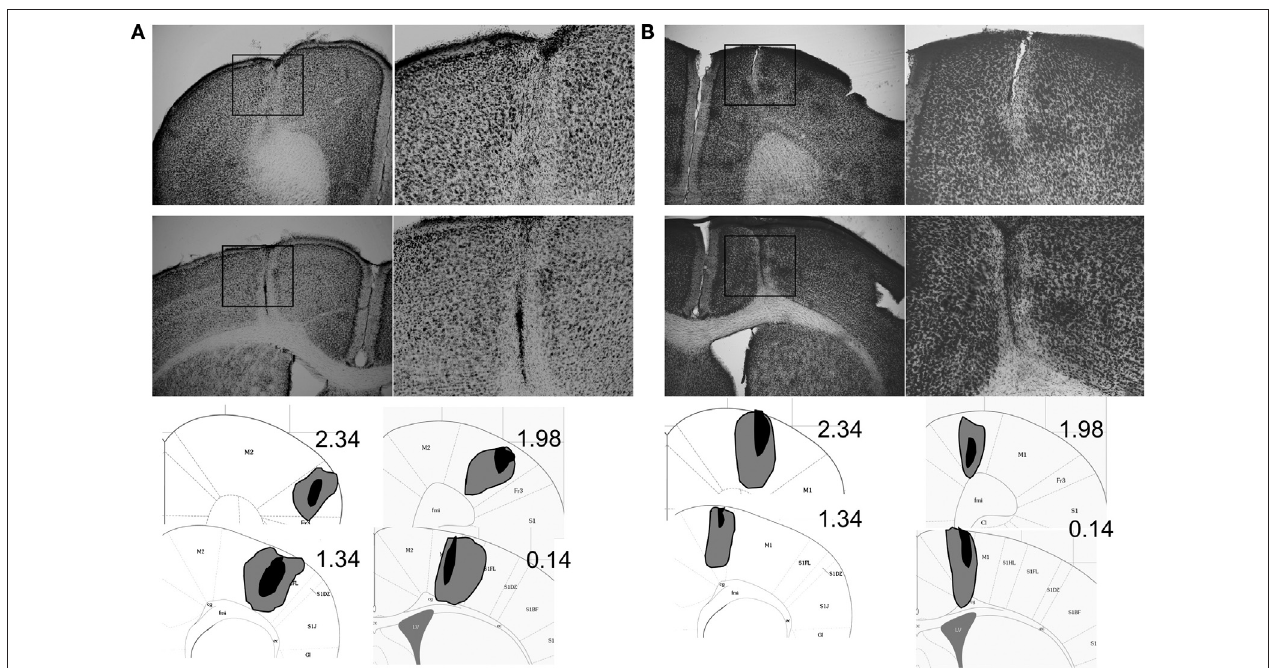
FIgure  | Histological analysis of motor cortex lesions. Photomicrographs of the M1 (A) and M2 (B) lesions. Representative lesions as well as illustration of the largest (gray) and smallest (black) extent of lesions are shown. The diagrams are based on a mouse brain atlas (Paxinos and Franklin, 2003). The numbers indicate distance in mm from bregma.